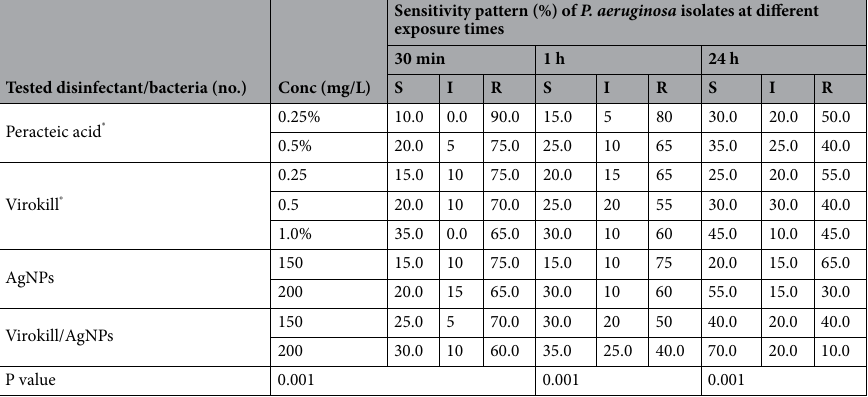
Tested disinfectant/bacteria